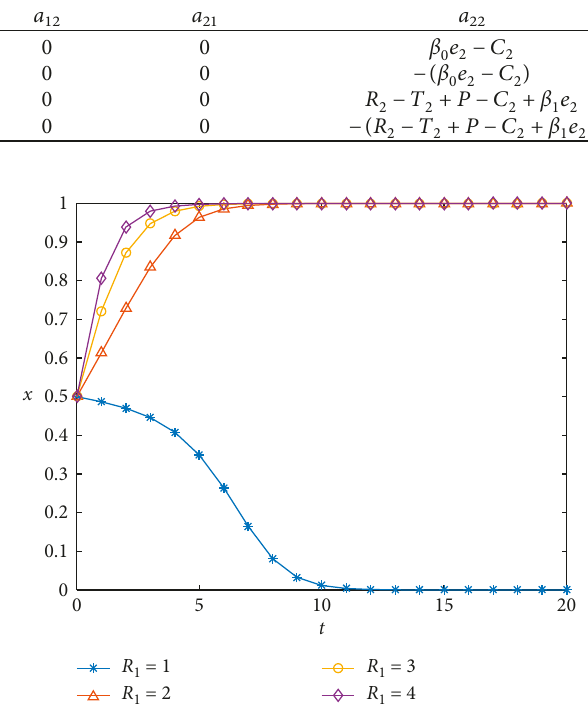
1 on the supplier.